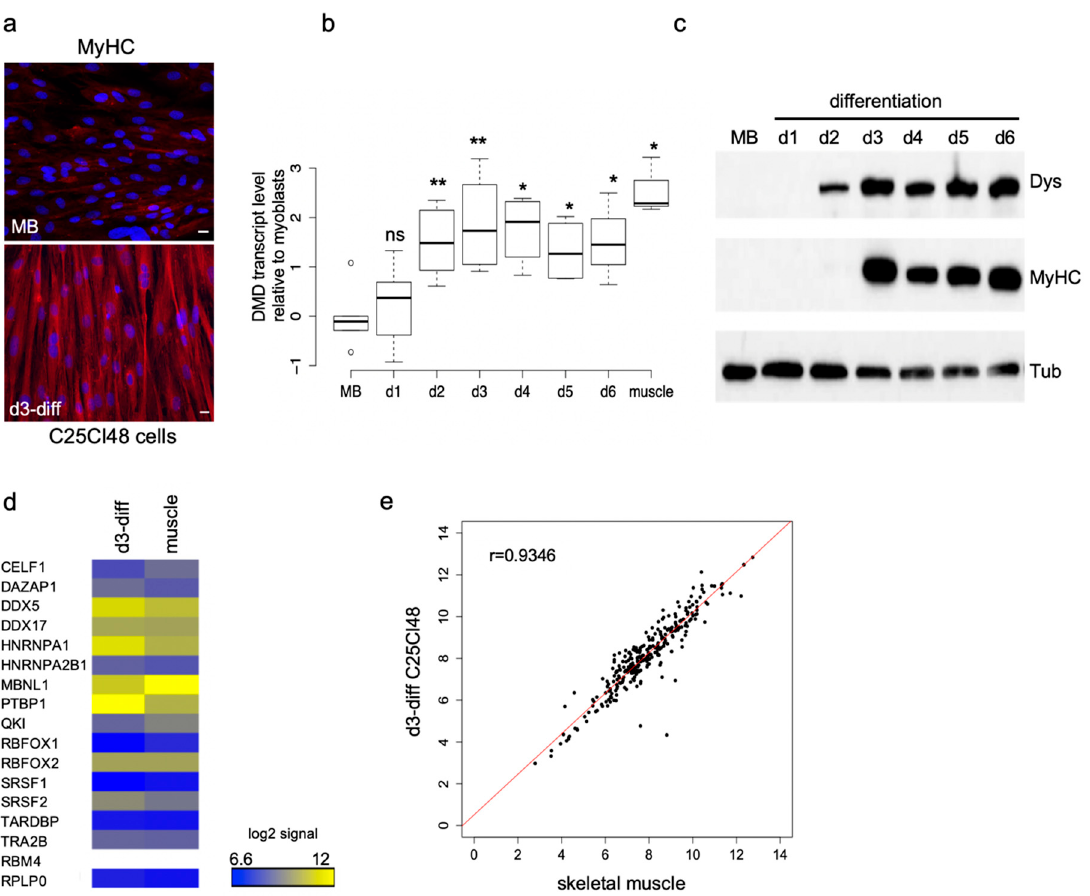
Figure 1. Time-course analysis of gene expression in C25Cl48 cells during myogenic differentiation. ( a ) Visualization of multinucleated myotubes in differentiated C25Cl48 cells. Proliferating myoblasts (MB) and three-days differentiated (d3-diff) C25Cl48 cells were fixed and stained with DAPI (cell nuclei in blue) and with the MY-32 antibody that recognizes all skeletal-muscle myosin (MyHC) isoforms (red). Specific antibody labeling was visualized using a Cy3-conjuguated secondary